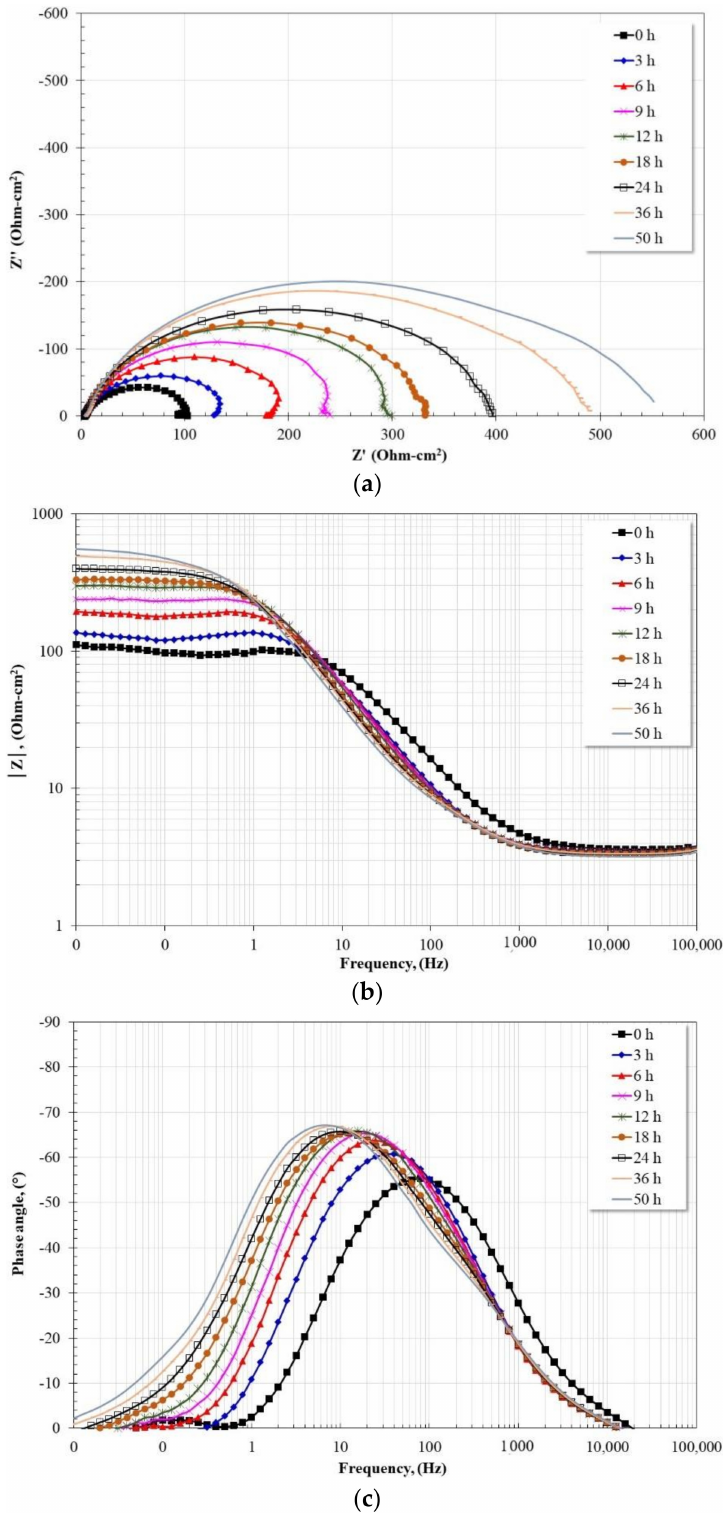
Figure 6. Evolution of Nyquist and Bode diagrams for 1018 steel in CO 2 -saturated brine at 60 ◦ C. ( a ) Nyquist diagram; ( b ) Bode diagram in its impedance modulus format; ( c ) Bode diagram in its phase angle